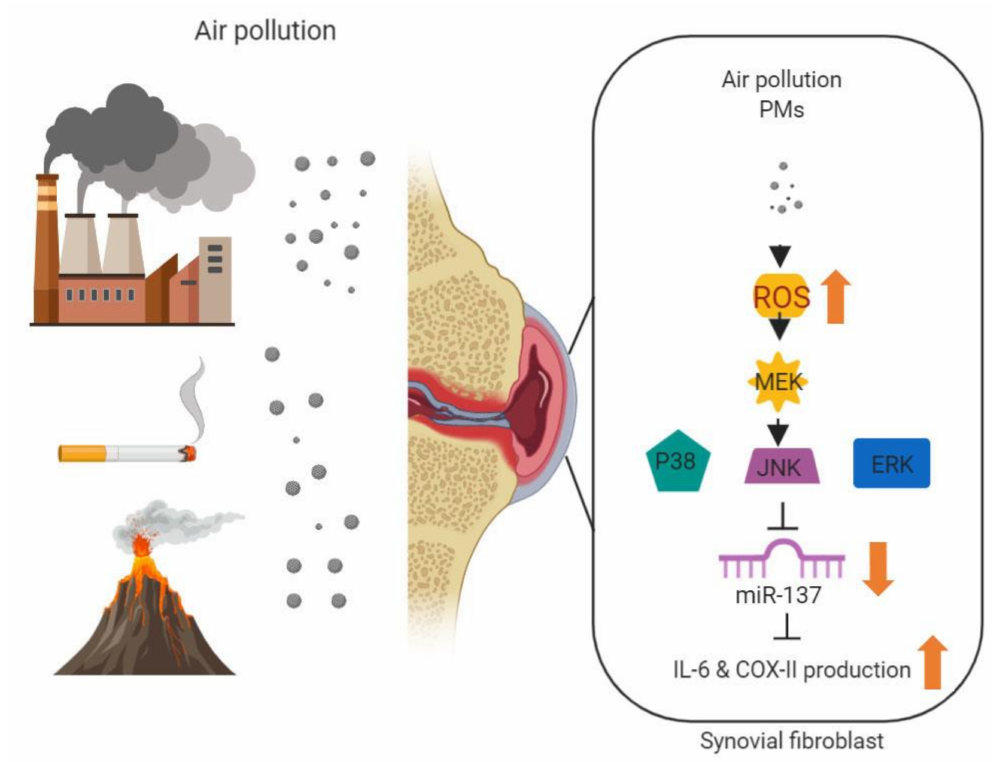
Figure 7. Schematic diagram illustrating the proposed signaling pathway involved in particulate matter (PM)-upregulation of IL-6 and COX-II expression via miR-137. PMs increase generation of reactive oxygen species (ROS) and in turn activate MAPK signaling pathways that cause increased IL-6 and COX-II through downregulation of